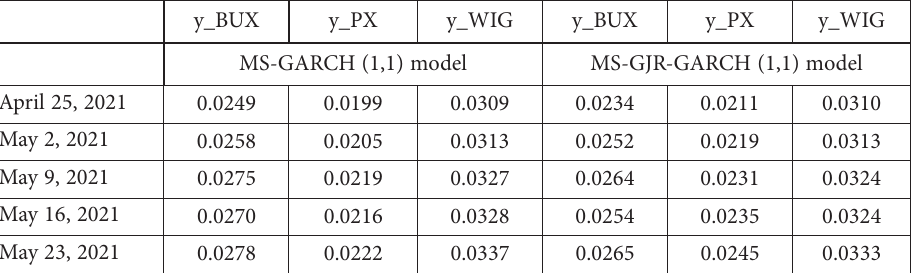
Table 5. Five-step ahead conditional volatilities of MS-GARCH (1,1)/MS-GJR-GARCH (1,1) models (source: own calculations in R, package “MSGARCH”) y_BUX y_PX y_WIG y_BUX y_PX y_WIG MS-GARCH (1,1)